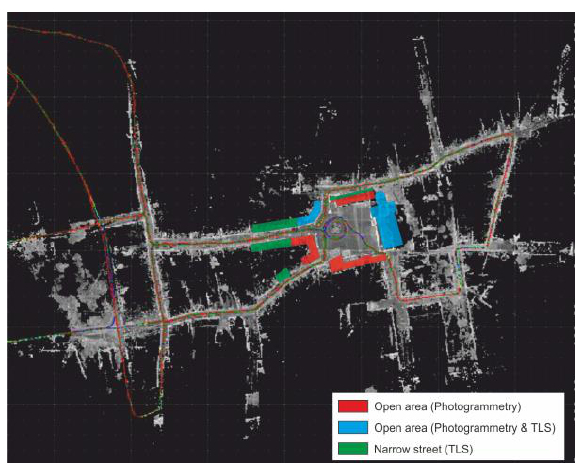
Figure 3. The trajectory of the area surveyed with the MMS and the buildings selected for statistical analyses in the square (red and blue symbols) and in the narrow streets (green symbols).